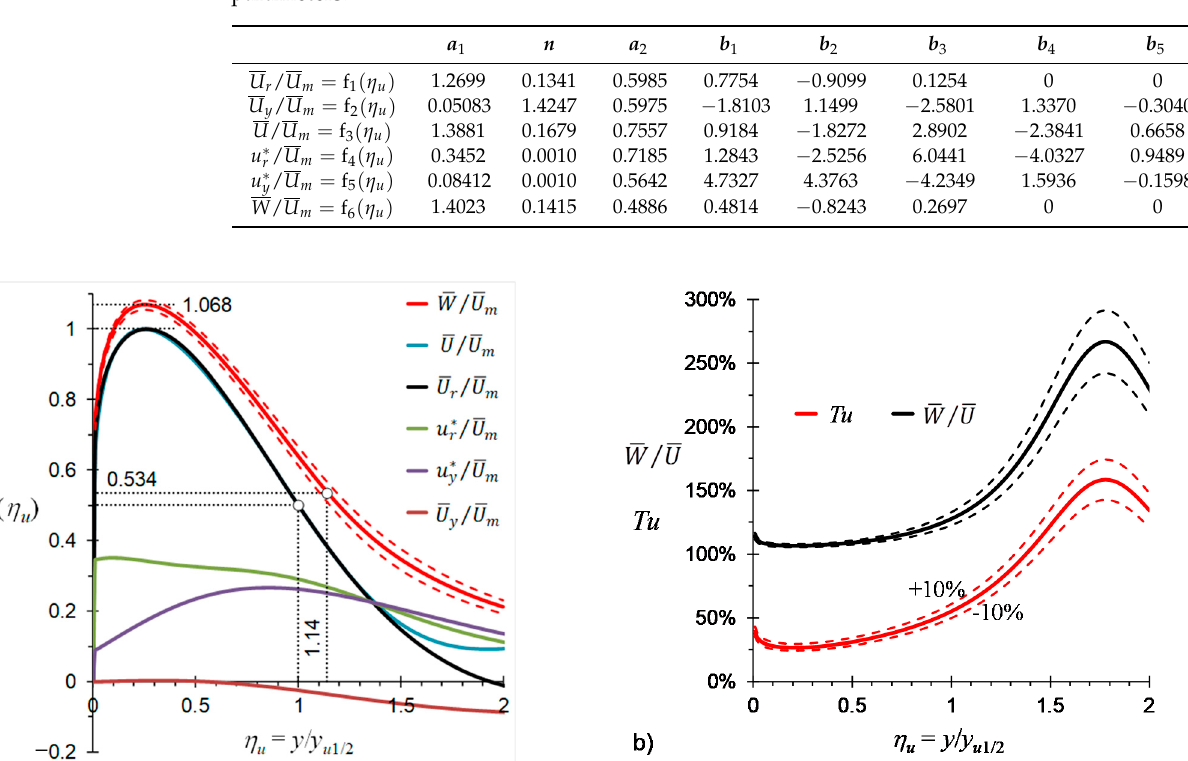
Table 1. The values of coefficients in Equation (7) describing the profiles of air velocity distribution parameters.